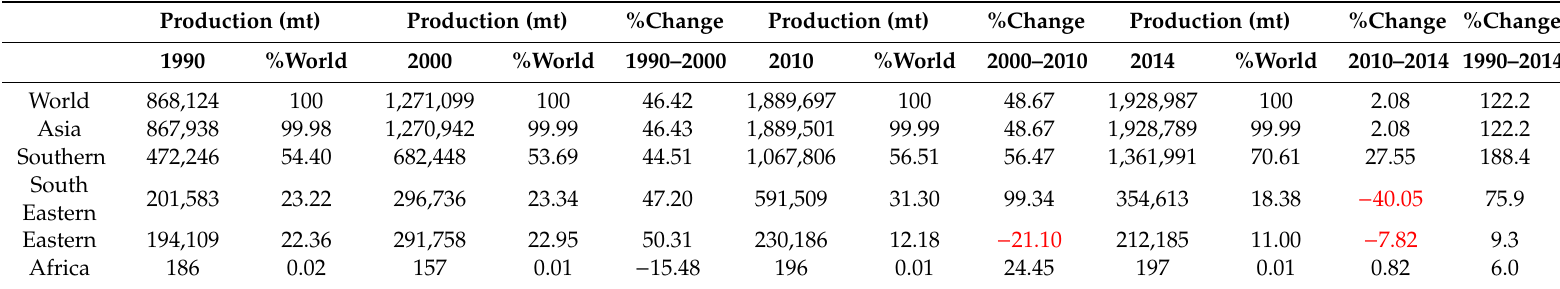
Table 2. Areca nut production by Asian region, 1990–2014.